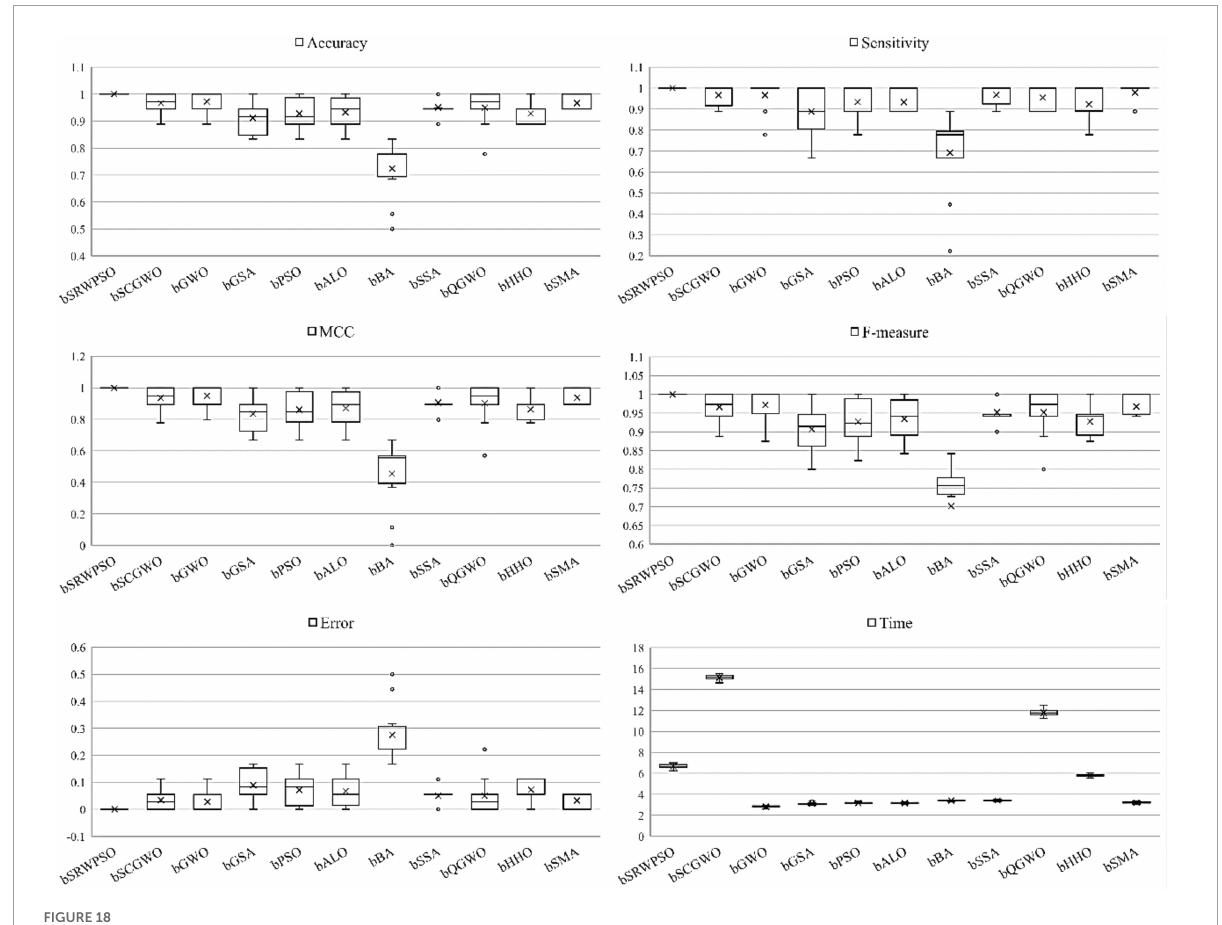
FIGURE18 Comparison results of bSRWPSO with other binary